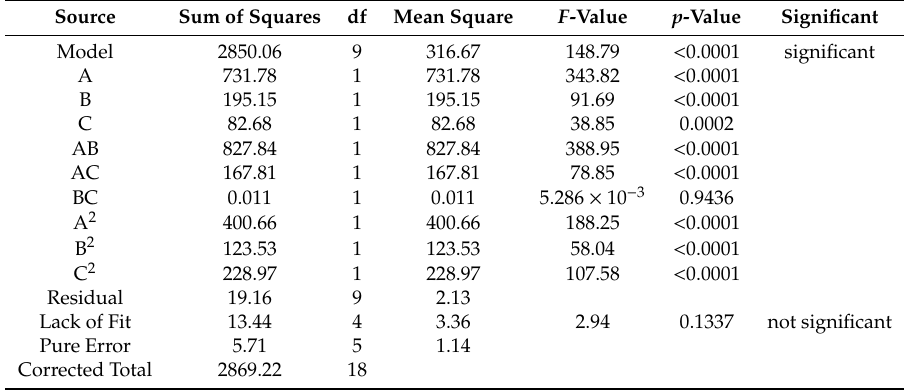
Table 2. ANOVA results for the e ff ect of all independent